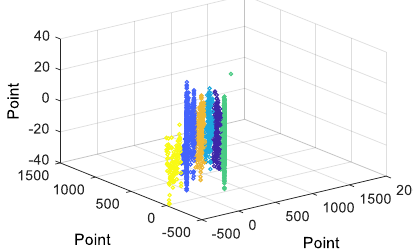
Figure 3. Dimensionality reduction results of Principal Component Analysis (PCA).